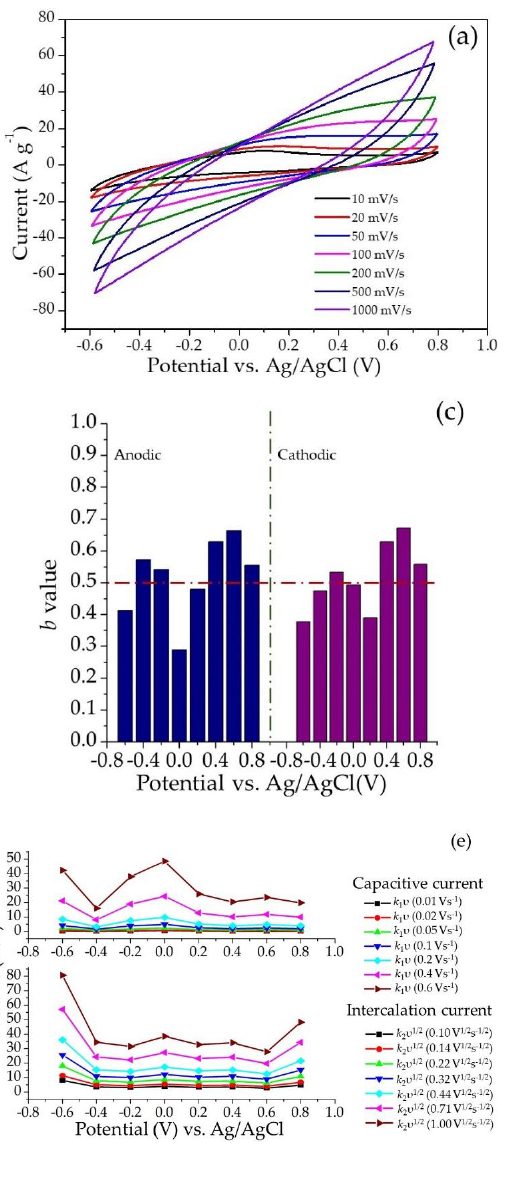
Figure 6. Electrochemical performance of semi-polycrystalline polyaniline-activated carbon (SPani- AC) composite in aqueous 1 N Na 2 SO 4 electrolyte: ( a ) cyclic voltammograms recorded at different scan rates ranging from 10 – 1000 mV s −1 ; ( b ) evolution of specific capacitance with respect to different scan rates; ( c ) ‘ b ’ value determination from peak anodic and cathodic currents (log i p vs. log scan rate); ( d ) linear fit plots of υ 1/2 vs. i ( V )υ 1/2 ; ( e ) variation of capacitive and intercalation currents as a function of potential; ( f ) variation of the ratio of capacitive and intercalation currents with scan rate. The specific capacitance ‘ C s ’ for the SPani-AC composite electroactive material was calculated by using Equation (1) [35]